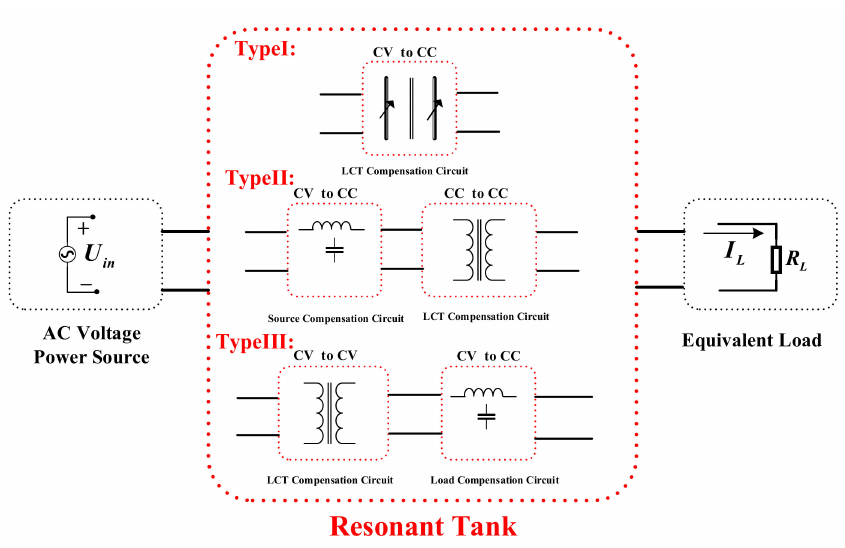
Figure 22. Design diagram for CC output in IPT systems.